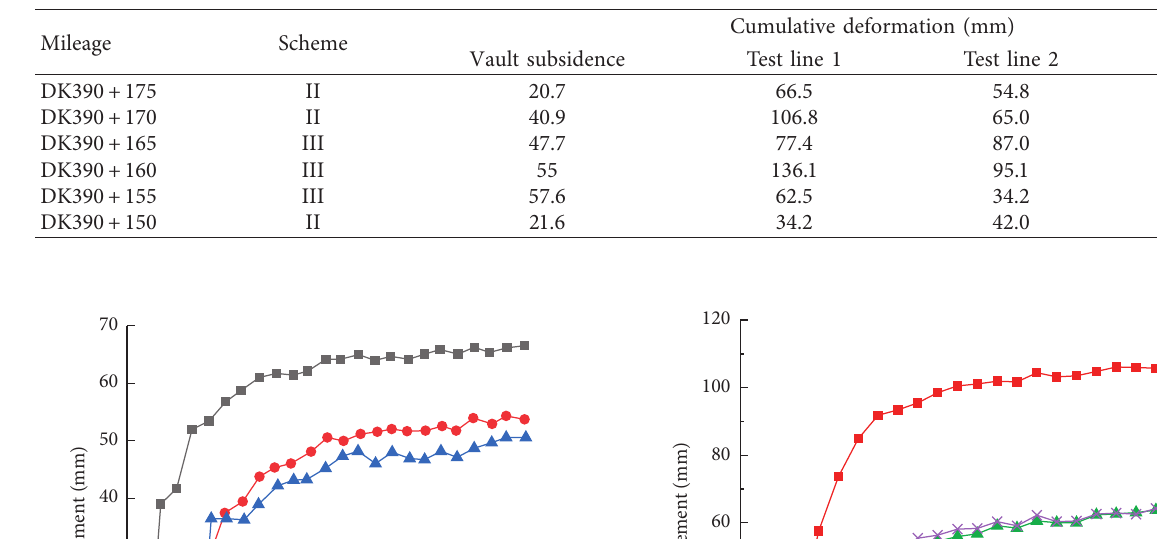
Table 2: Statistical table of displacement monitoring